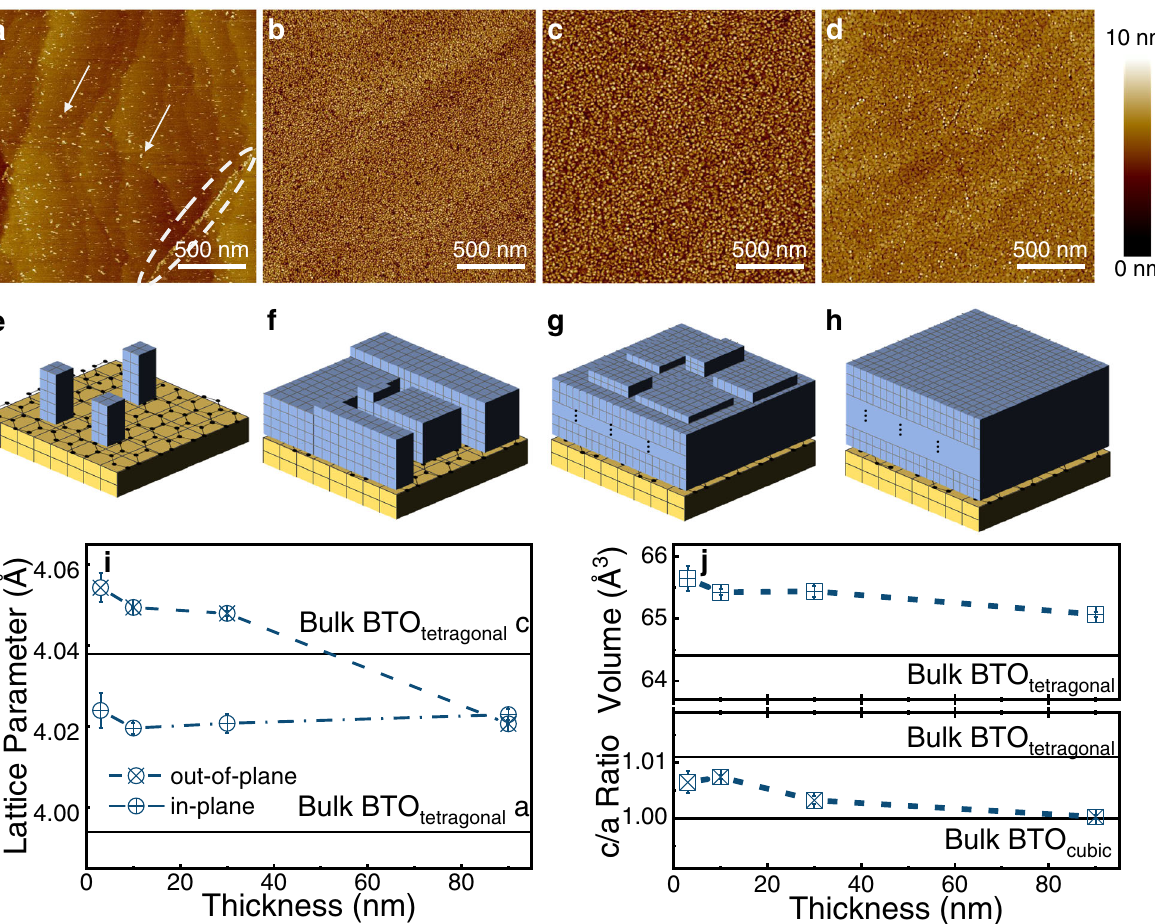
Fig. 3 Growth mode and strain relaxation of remote epitaxial BTO fi lms. AFM images of BTO fi lms grown with different equivalent thicknesses: a 0.3 nm; arrows mark two of the separated islands and the wrinkle serving as the nucleation center was denoted; b 3 nm, c 10 nm, and d 90 nm. The schematic illustration of the fi lm growth process: e Three-dimensional epitaxial islands nucleation following the Volmer-Weber mode, corresponding to a ; f islands coalescing, corresponding to b ; g and h formation of a fl at fi lm, corresponding to c and d . i Evolution of the lattice parameter as a function of the fi lm thickness. The error bars are de fi ned by the peak fi tting of the XRD results shown in Fig. S15. j Evolution of the c/a ratio (lower) and lattice volume (upper) as a function of the fi lm thickness. The error bars were calculated based on the results in i